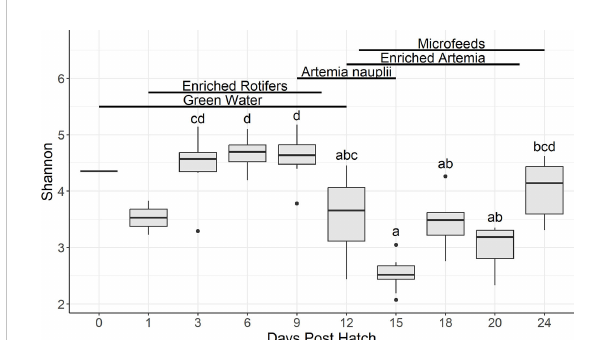
FIGURE 6 Principal coordinates of analysis of larvae samples using a Bray- Curtis dissimilarity matrix. Color represents days post hatch with yellow representing samples taken 3 days post hatch, dark blue 6 days post hatch, black 9 days post hatch, green 12 days post hatch, brown 15 days post hatch, light blue 18 days post hatch, gray 20 days post hatch, and orange 24 days post hatch. Shape represents salinity with circles representing samples that were at 10 ppt, triangles 20 ppt, and squares 30